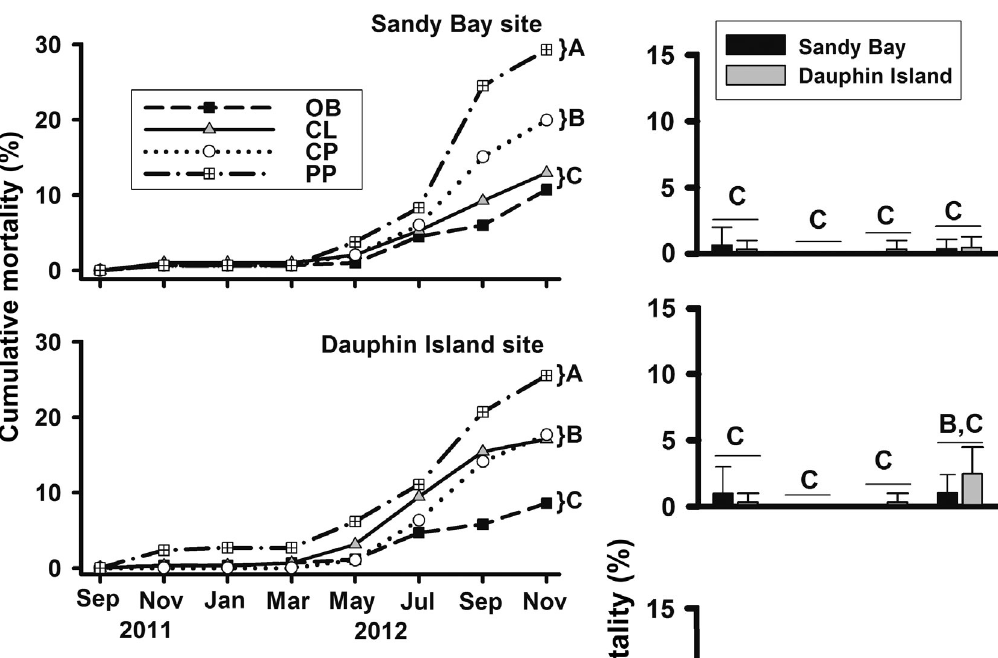
Fig. 4. Cumulative mortality of Louisiana eastern oysters from the OBOY (OB) and Calcasieu Lake (CL) stocks, and Alabama oysters from the Cedar Point (CP) and Perdido Pass (PP) stocks at the Sandy Bay and Dauphin Island study sites. Stocks that do not share a letter have cumulative mor- talities that are significantly different at the end of the study (p < 0.05)